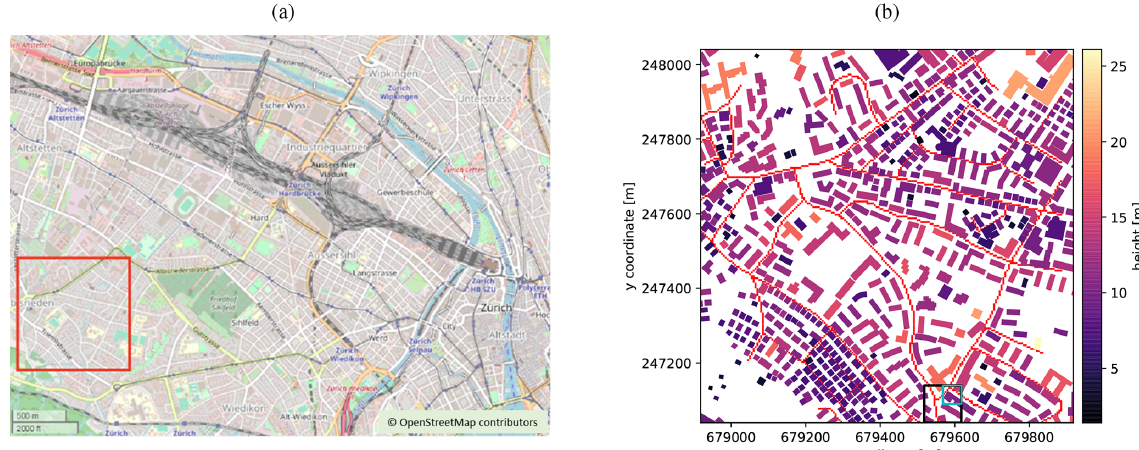
Figure 1. (a) Map of Zurich with the location of the study area in red. Map information was obtained from OpenStreetMap (© OpenStreetMap contributors 2021 distributed under the Open Data Commons Open Database License (ODbL) v1.0.). (b) Building heights and major roads in the study area with the lower left pixel at x = 678918 and y = 247040m in the Swiss LV03 coordinate system. The black square represents the location of the subdomain and the cyan square the location of a single pixel observation both used in Sect. 3.3.